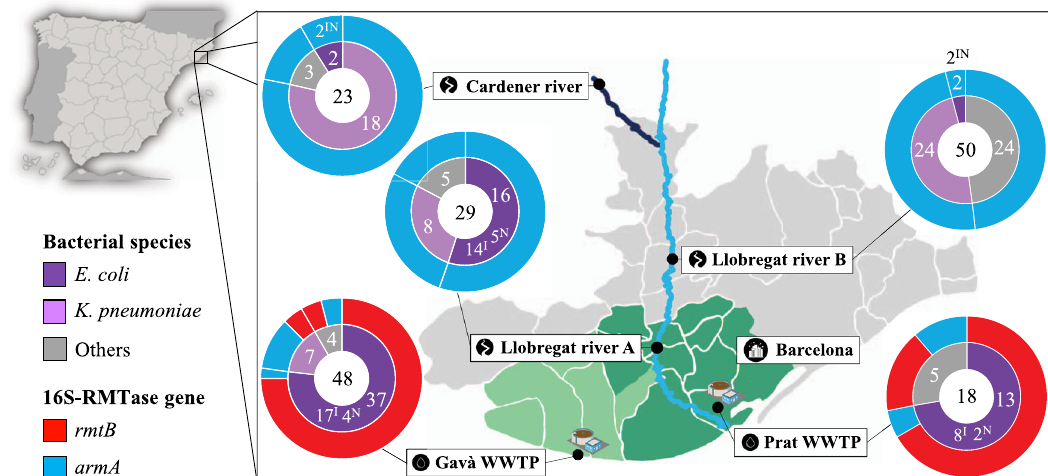
Fig. 1 Geographical distribution of sampled points in the region of Barcelona (Spain). The location of Barcelona city is indicated by black circled city icon. The Llobregat river is presented in light blue and the Cardener river in dark blue. The three river sampled locations are indicated by black circled river icon. The two sampled WWTPs are indicated by black circled droplet icon. The collection area of the El Prat WWTP is highlighted in dark green, whereas the area of the Gavà WWTP is highlighted in pale green, collecting the wastewater of 2,000,000 and 370,000 inhabitants, respectively. Total number of pan- aminoglycoside-resistant bacteria collected from each sampling location is indicated in the center of the sunburn diagrams. Inner rings represent the proportion of different pan-aminoglycoside-resistant bacterial species identi fi ed in each sampling location, indicating the total number of E. coli , K. pneumoniae and other species, and the number of E. coli isolates selected for later Illumina ( I ) and Nanopore sequencing ( N ). Outer rings show the 16S-RMTase gene harbored by these